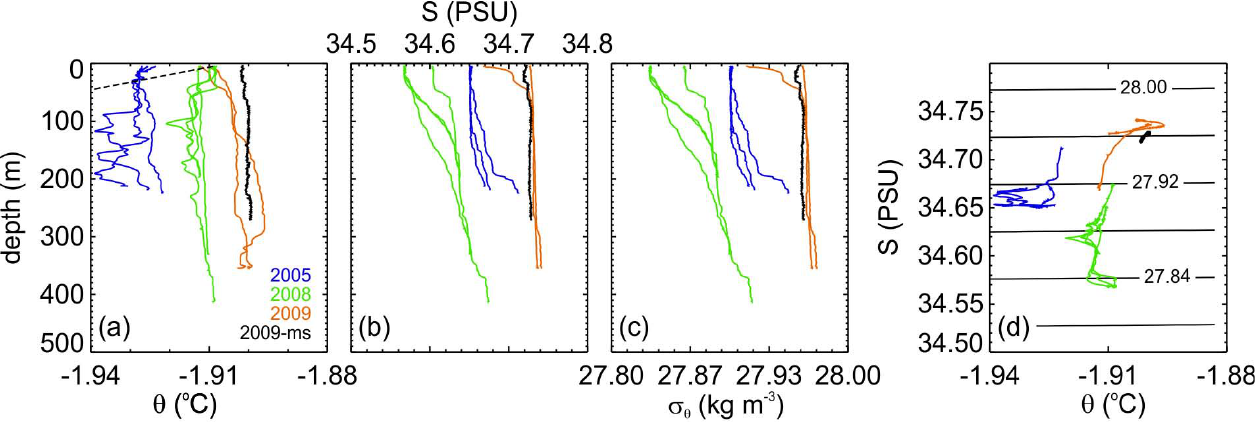
Fig. 9. (a) Potential temperature, (b) salinity, (c) potential density anomaly profiles at various locations within 500m of the tip of the EGT from the October–November period during 2005, 2008 and 2009, plus a single representative example from the present microstructure data (2009ms). The dashed line in the upper part of (a) is the freezing temperature at a nominal salinity of 34.65PSU. The maximum depth from the 2005 profiles were limited by operational issues. The other CTD profiles all penetrated to within 20m of the bed indicating the large variation in depth in the region. (d) Shows the − S relationship superimposed onto potential density anomaly lines.